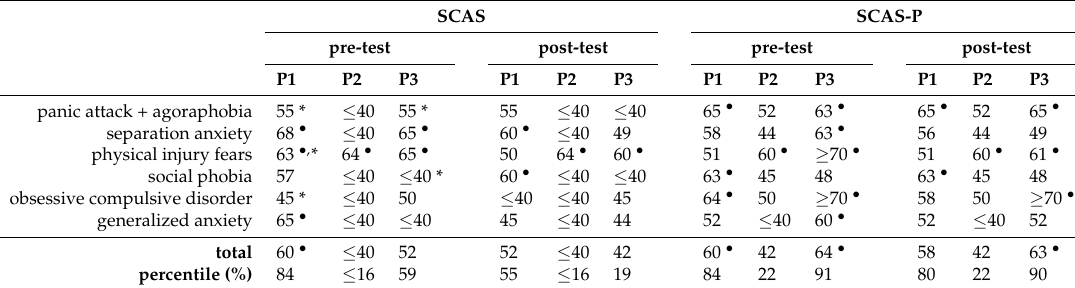
Table 8. T-scores of the Spence’s Children Anxiety Scale (SCAS) and Spence Children Anxiety Scale-Parents (SCAS-P)